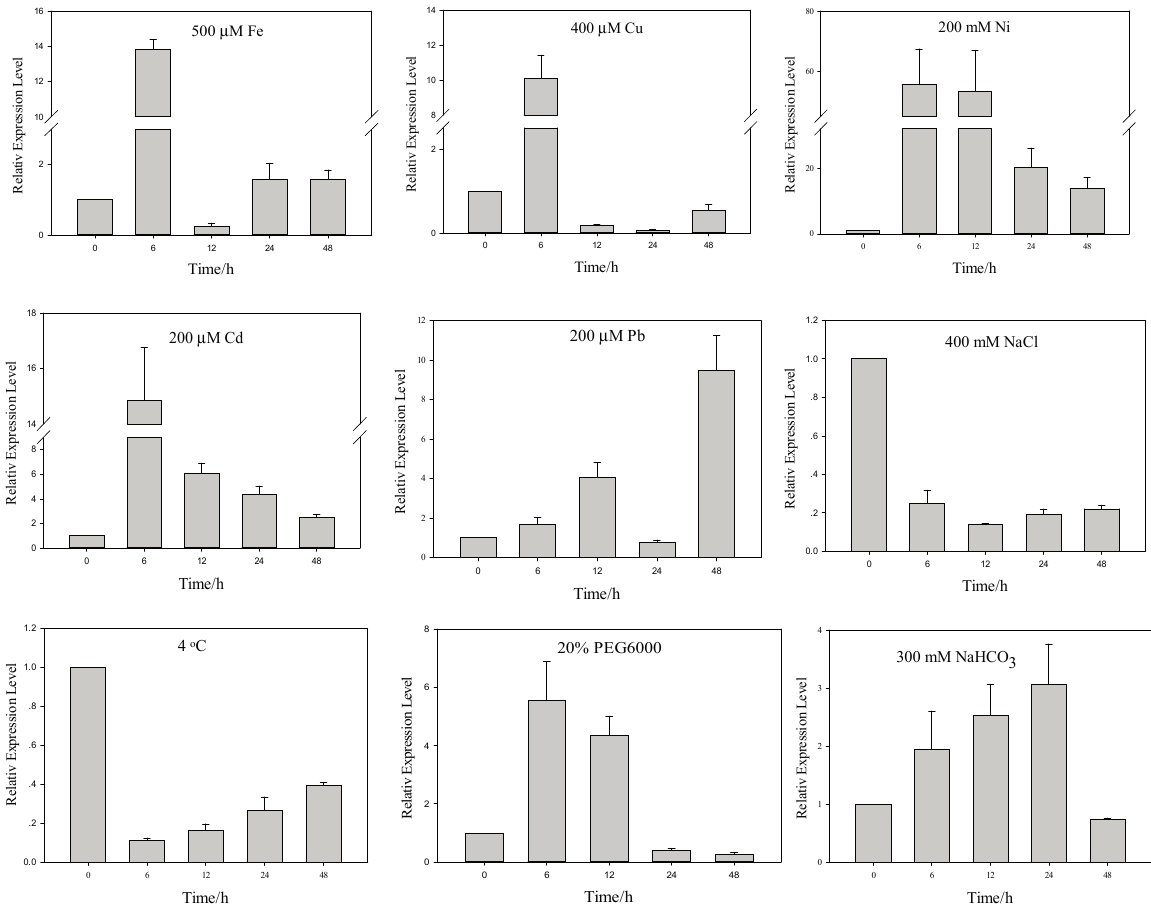
Figure 2. Quantitative RT-PCR validation of AcHMA1 under 500 µM Fe, 400 µM Cu, 200 µM Ni, Cd and Pb, 400 mM NaCl, 300 mM NaCHO temperature treatments. EF1 α was used as the internal control. Relative expression levels of AcHMA1 in stress treatments were plotted as the relative expression fold of the non-treated seeding (0 h) for 6, 12, 24 and 48 h. Error bars: standard